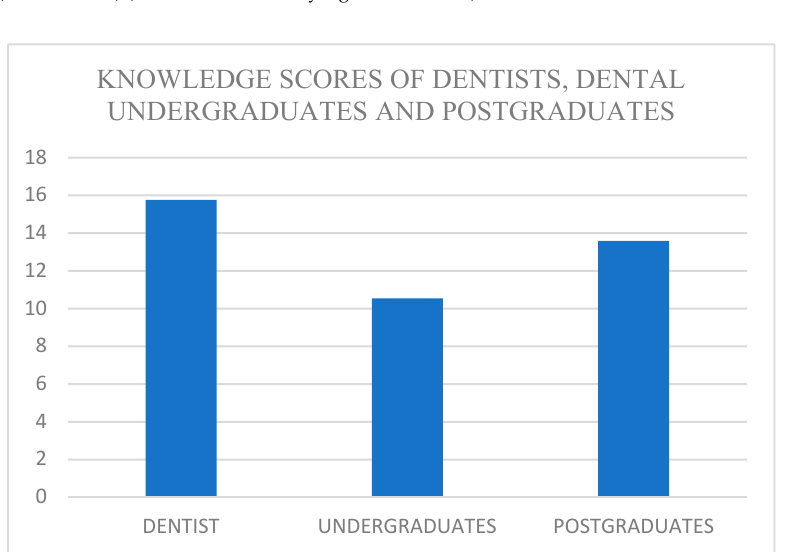
Figure 3. Knowledge scores of dentists, dental undergraduates, and postgraduates.